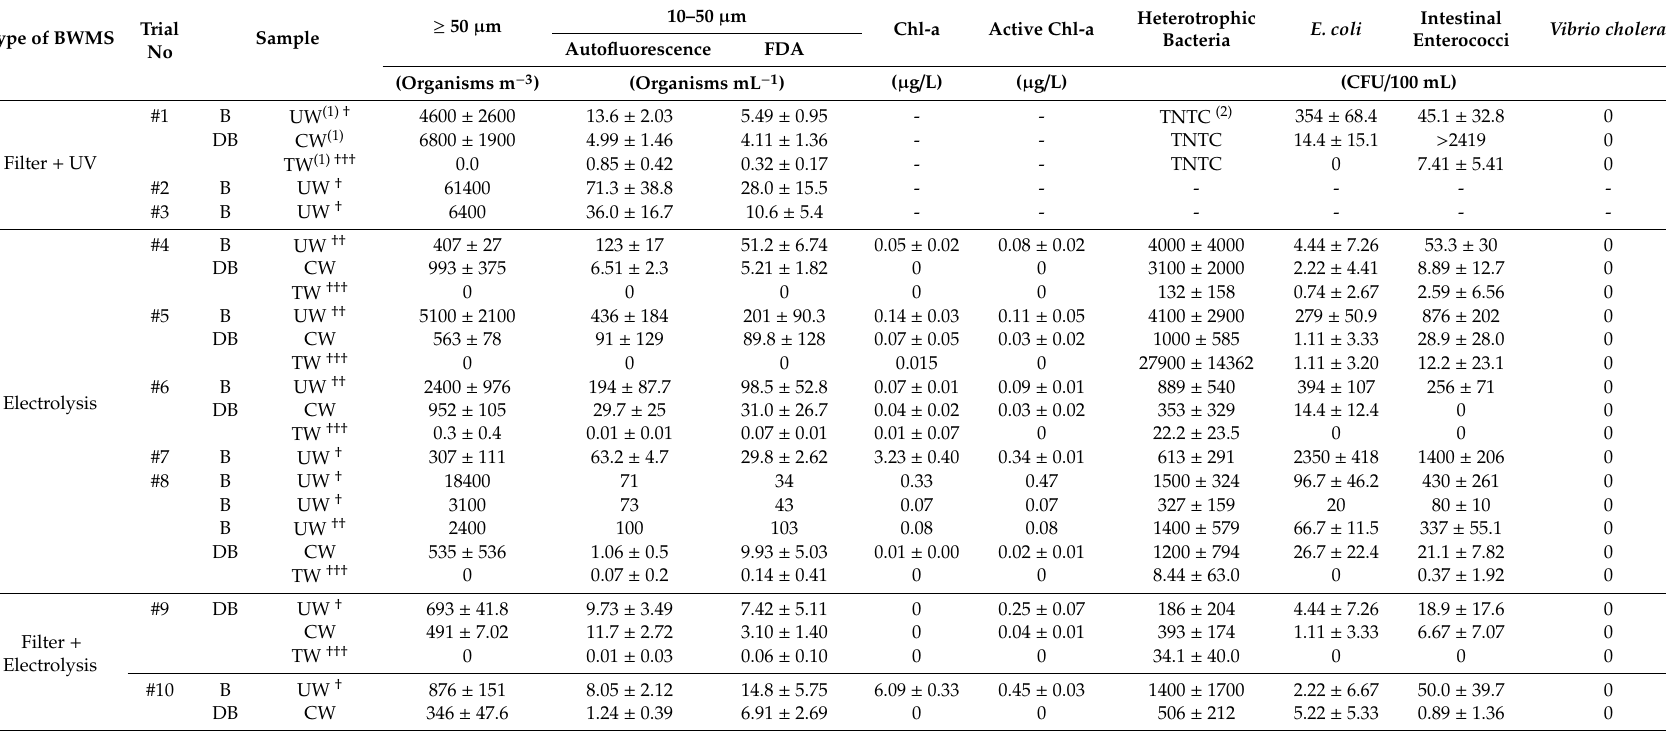
Table 5. Biological parameters in ballasting and deballasting waters for three types of BWMS installed on